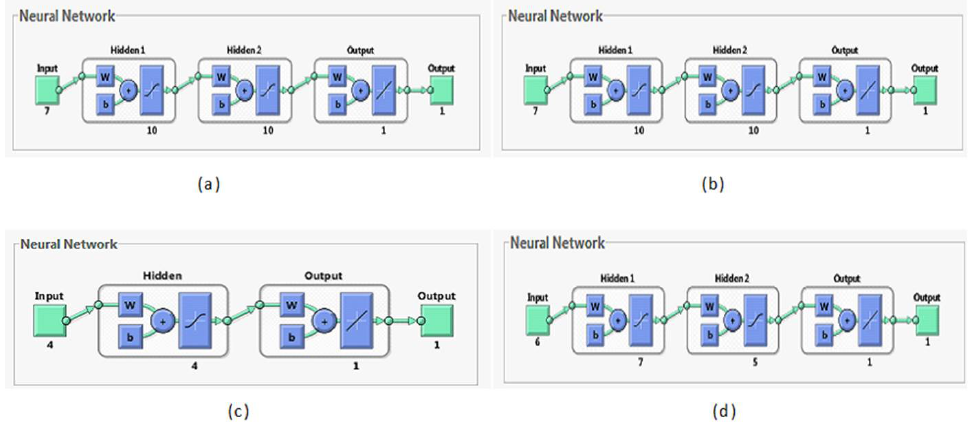
Figure 8. Structure of ANN models for (a) winter (b) spring, (c) summer and (d)